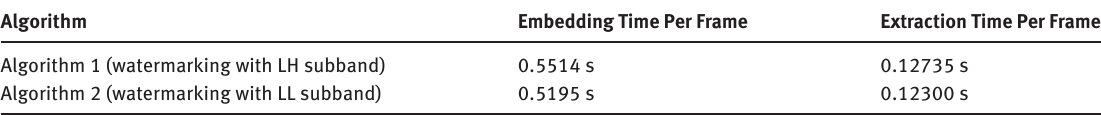
Table 11: Embedding and Extraction Time per Frame.